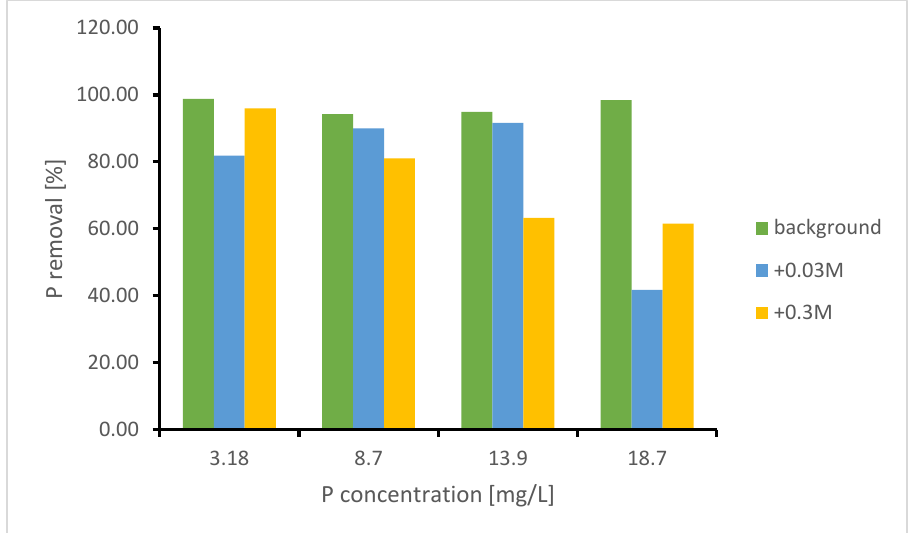
Figure 5. Effects of ionic strength on phosphorus removal efficiency (adsorbent dose = 1 g/L, agitation speed = 200 rpm, temperature = 25 °C ± 2 °C, contact time = 60 min).